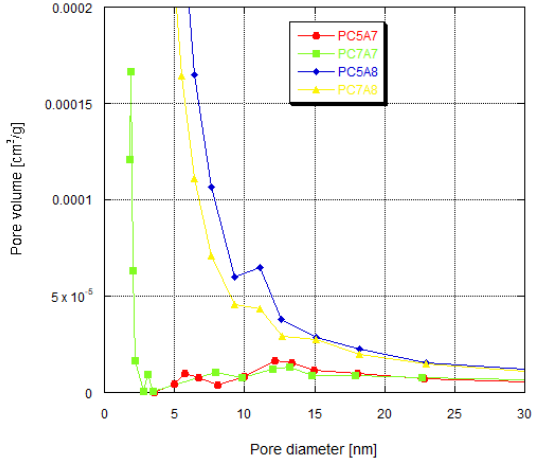
Figure 12. Pore size distribution for activated carbons prepared.